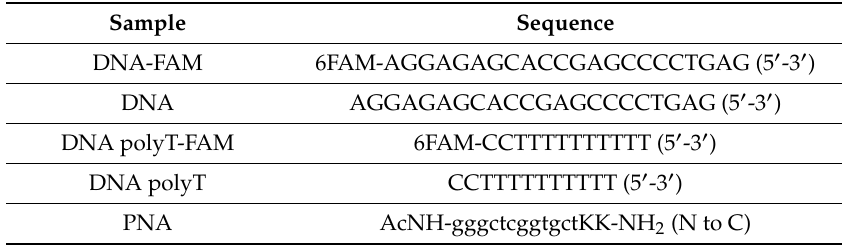
Table 1. Complementary (DNA-FAM and DNA) and not-complementary (DNA polyT-FAM and DNA polyT) DNA target and PNA sequences synthetized by solid-phase